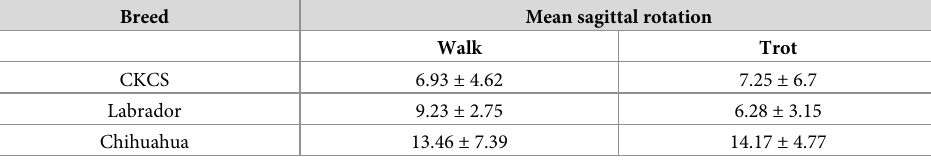
Mean sagittal rotation in ˚, for all strides in all CKCSs, Labrador retrievers and Chihuahuas in walk and